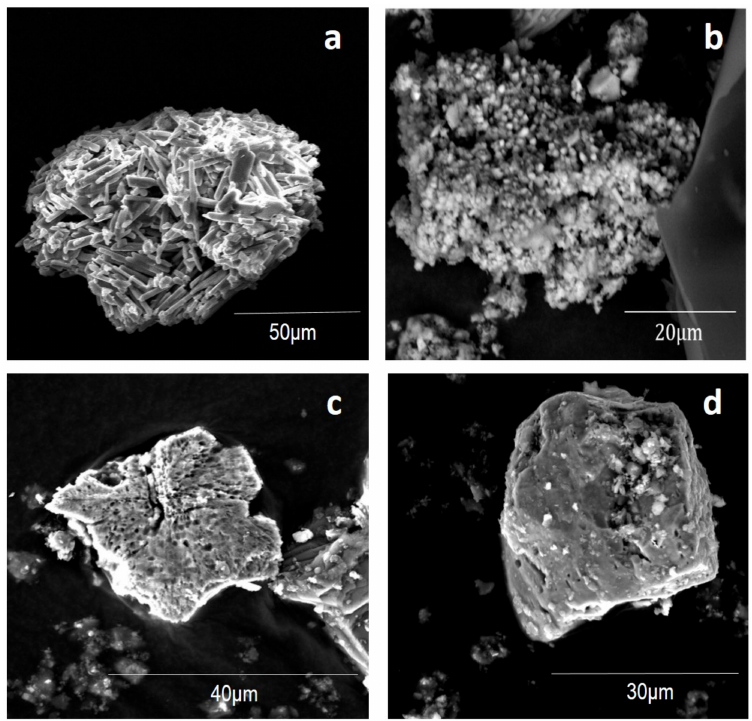
Figure 3. Secondary electron SEM images of secondary Ca precipitates and pyrite: Ca sulfate (possibly gypsum) found at week 12 in lime + silicate ( a ); Ca carbonate (possibly calcite) found at week 20 in lime + silicate + cover ( b ); pyrite sampled from the control at week 20 (around pH 2) ( c ); pyrite sampled from lime + silicate + cover at week 20 (around pH 12) ( d